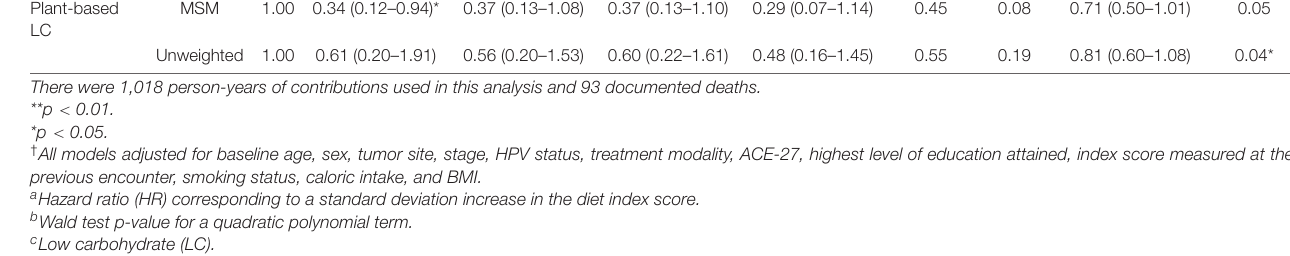
( Figure 3 ). Adjusted survival curves were generated from the MSMs ( Figure 4 ) and visually depicted the relationships